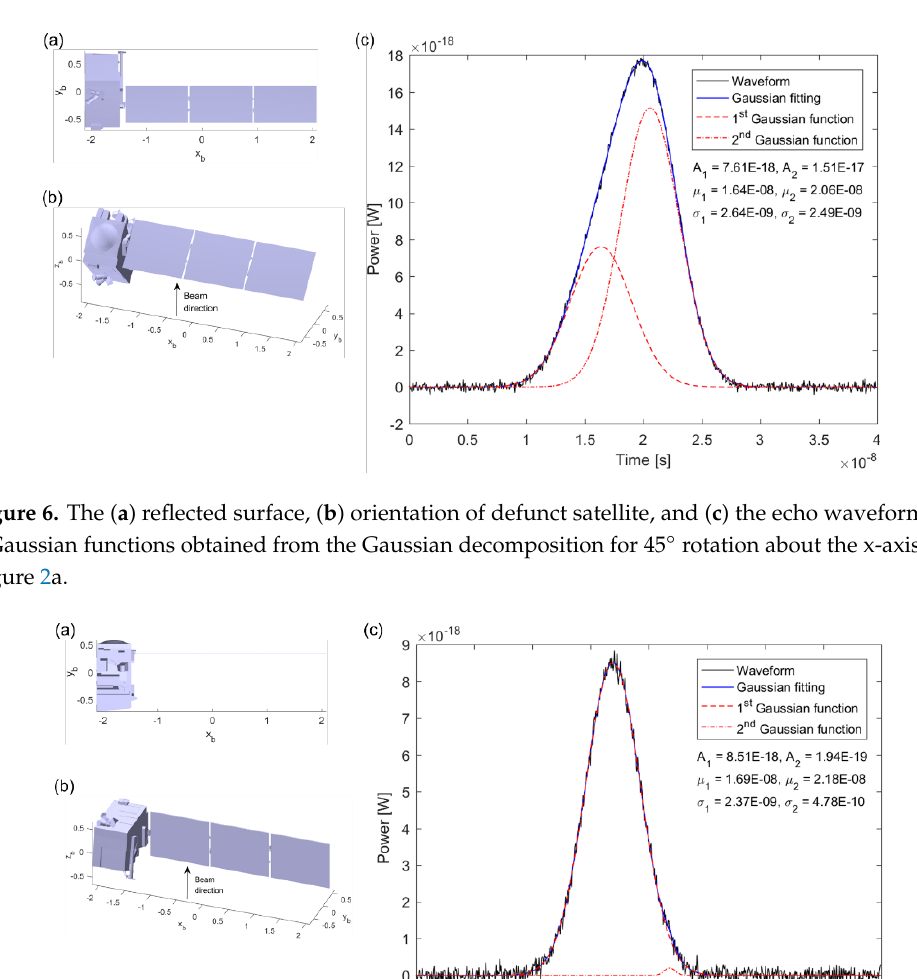
Figure 5. The ( a ) reflected surface, ( b ) orientation of defunct satellite, and ( c ) the echo waveform and 2 Gaussian functions obtained from the Gaussian decomposition, for no rotation w.r.t. Figure 2a.